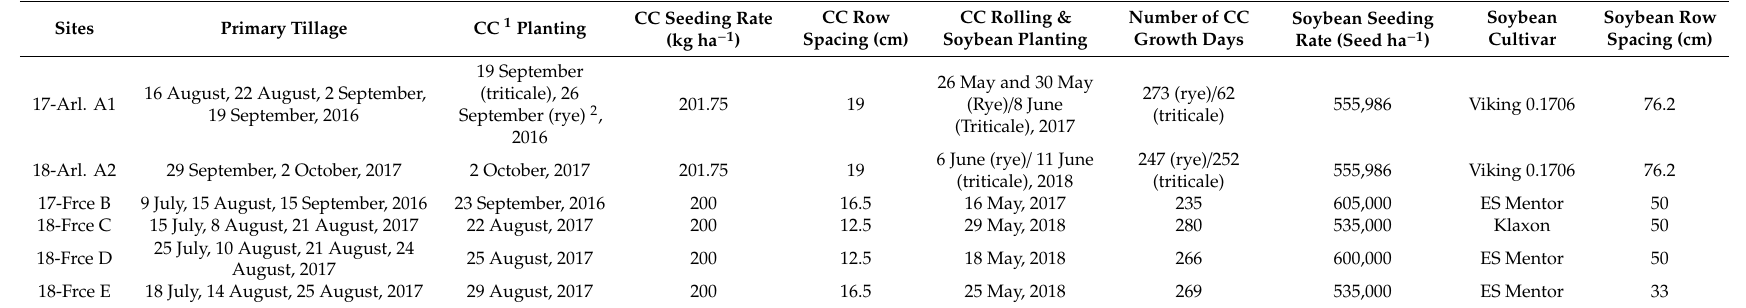
Table 2. Field operations at the di ff erent experimental